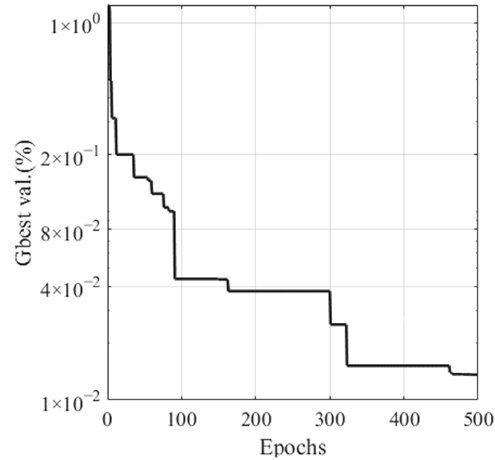
Figure 3. The convergence curve of NN-PSO.